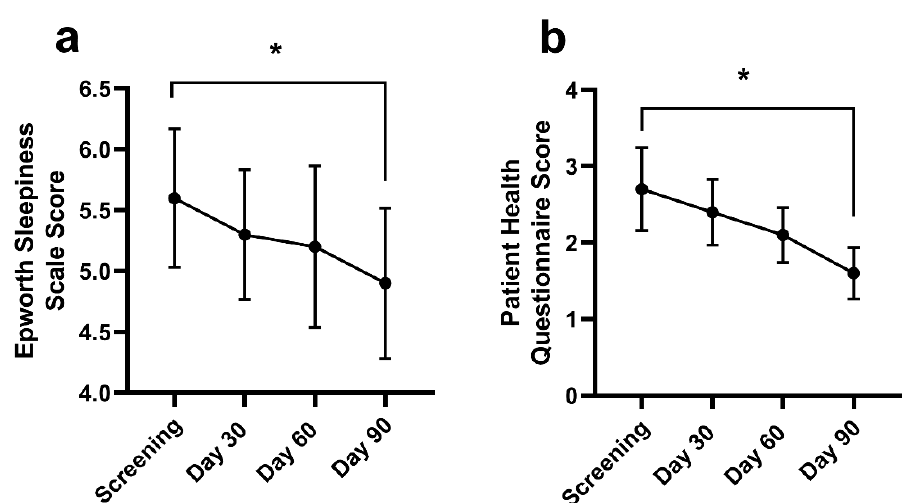
Figure 5. The Epworth Sleepiness Scale (ESS; ( a )) and Patient Health Questionnaire (PHQ; ( b )) at screening, Days 30, 60, and 90. Data are mean ± standard deviation. The ESS and PHQ were assessed using a repeated measures mixed effects model with visit number as the fixed effect and participant as the random effect. * Significantly different from screening at Day 90 ( p < 0.05).